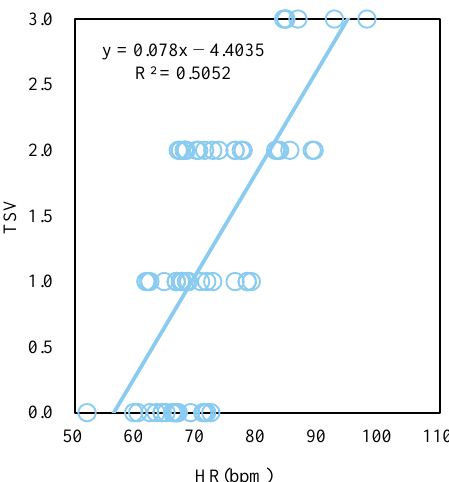
Figure 10. Relationships between TSV and HR.